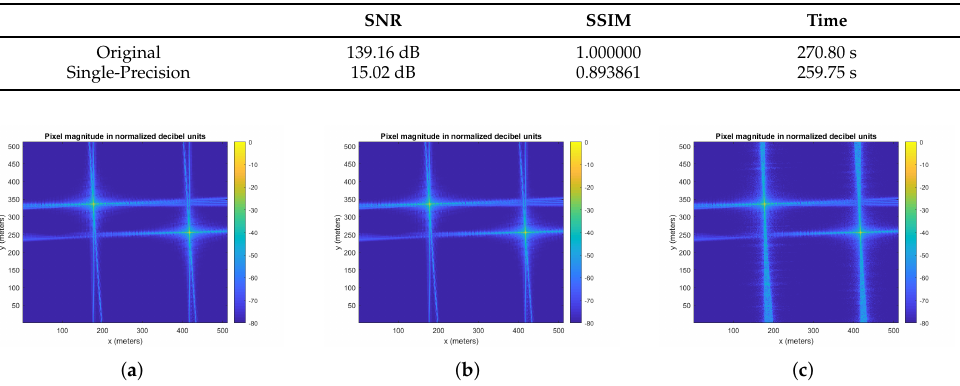
Table 10. Comparison of image quality and execution time for the small dataset of the PERFECT suite between the original version and the float-only. These images are compared to the golden reference, which is provided with the dataset.